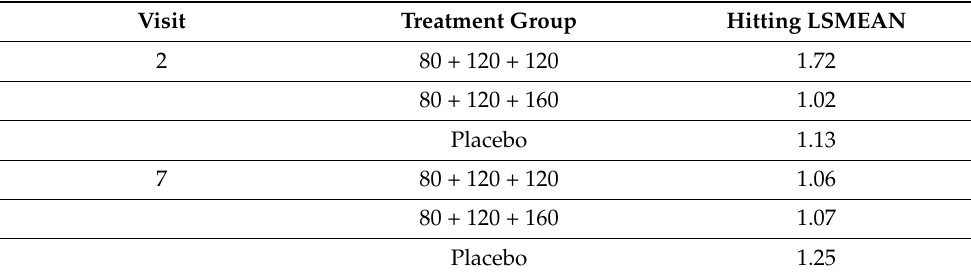
Table 6. Study Partner Reported Hitting, CMAI Scale, and LS means by Treatment and Visit, Per Protocol